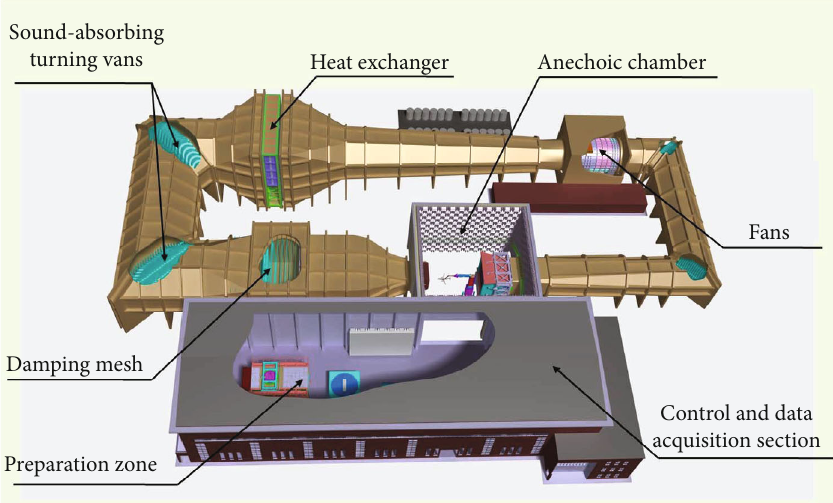
Figure 1: Overall structure of the 5 : 5 m × 4m Aeroacoustic Wind Tunnel at